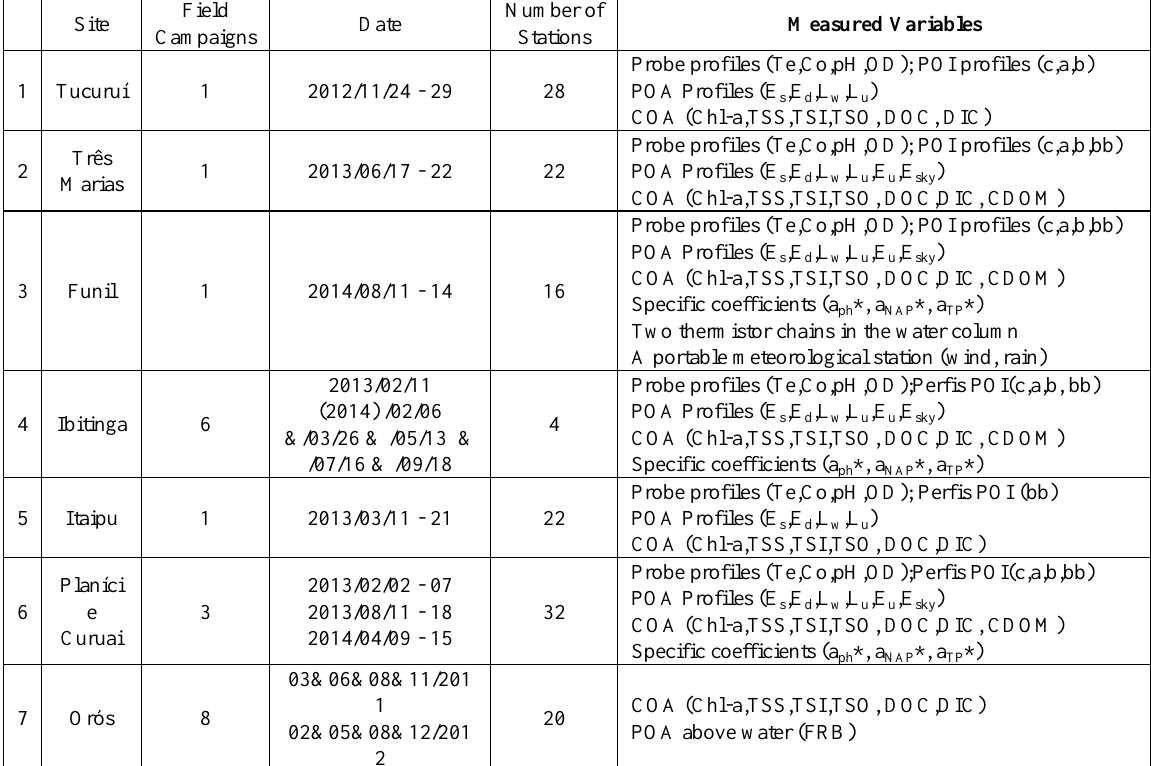
Table 1. Summary of measurements in field campaigns between 2012 and 2014 in six selected sites. [Te] temperature; [Co] conductivity; [Tu] Turbidity; [OD] Dissolved Oxygen; [FRB] Bidirectional reflectance factor; [E s ] incident surface irradiance; [E d , E u ] downwelling and upwelling irradiance in the water column; [L w ] water-leaving radiance; [Lu] upward radiance during profile; c = total attenuation; a = total absorption; b = total scattering; b b = total backscattering coefficient; [Chl-a] chlorophyll; [TSS] Total Suspended Matter; [TIS] Total Inorganic Solids; [TOS] Total Organic Solids; [DOC] Dissolved Organic Carbon; [DIC] Dissolved Inorganic Carbon; [CDOM] Coloured Dissolved Organic Matter; [a ph *] = phytoplankton-specific absorption coefficient; [a TP *] total particulate specific absorption coefficient; [a NAP *] = Non-Algal Particles-specific absorption